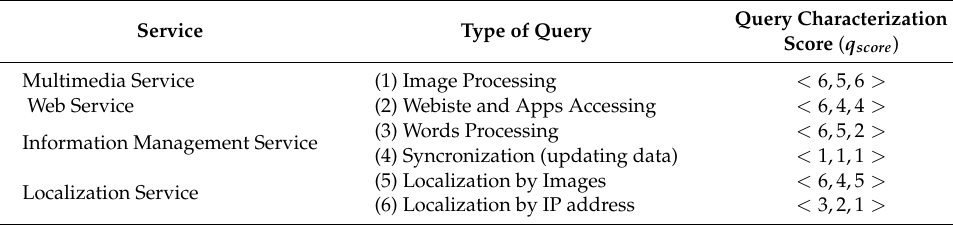
Table 5. Query Characterization Score for the motivating